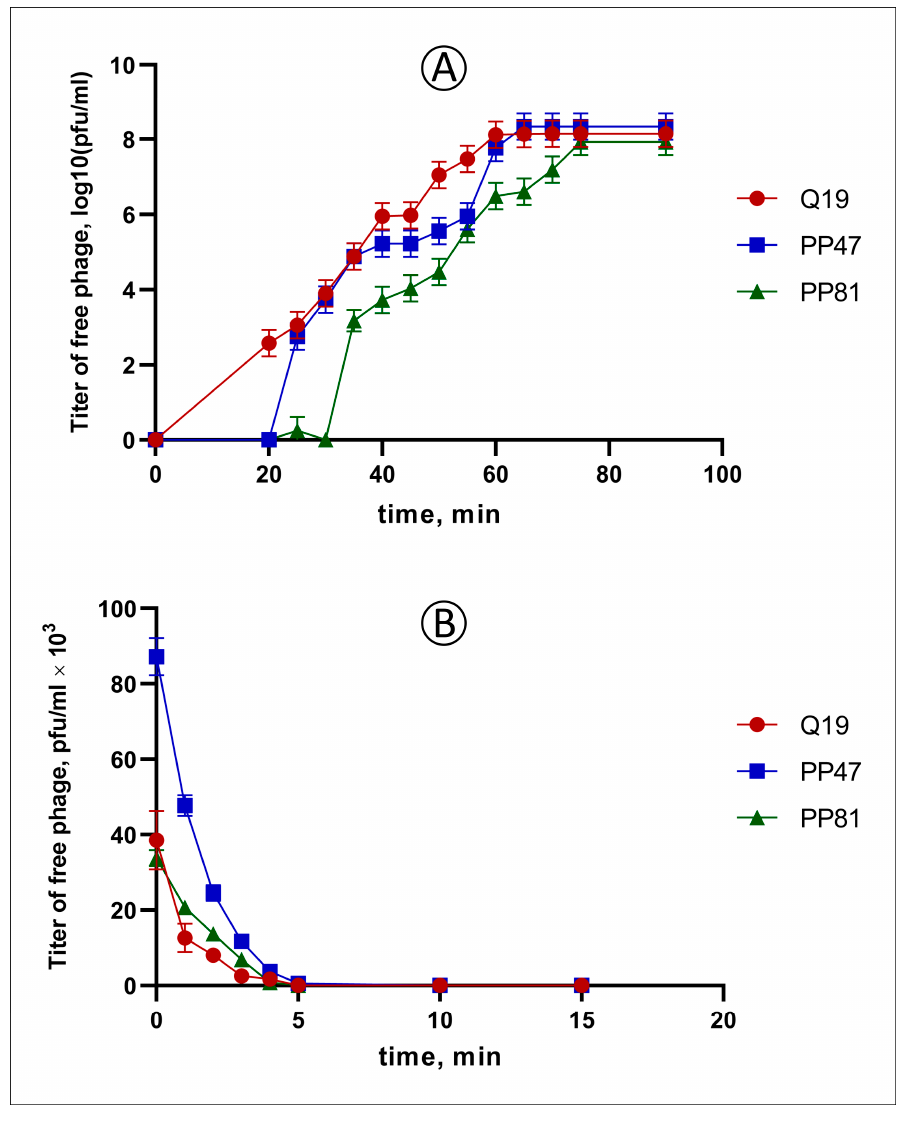
Figure 1. ( A ) One-step growth curve of phages Q19 (red), PP47 (blue) and PP81 (green) using P. brasiliense F157 as host strain in MOI = 0.01. ( B ) Adsorption of phages Q19 (red), PP47 (blue) and PP81 (green) at the surface of P. brasiliense F157 in MOI = 0.001.